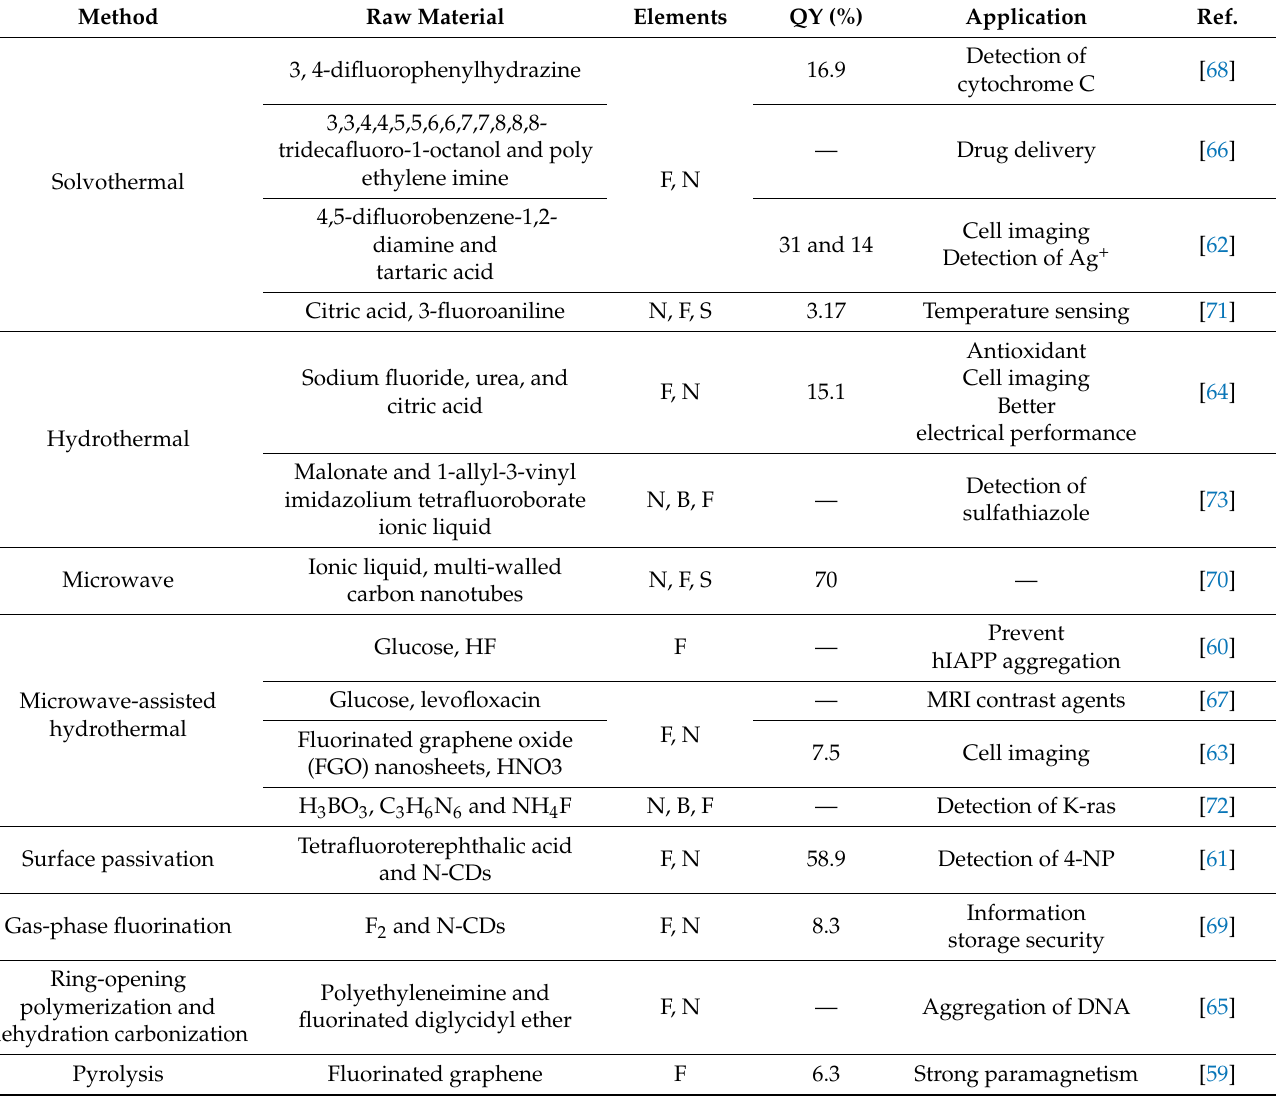
Table 1. Synthesis methods, raw materials, and applications of